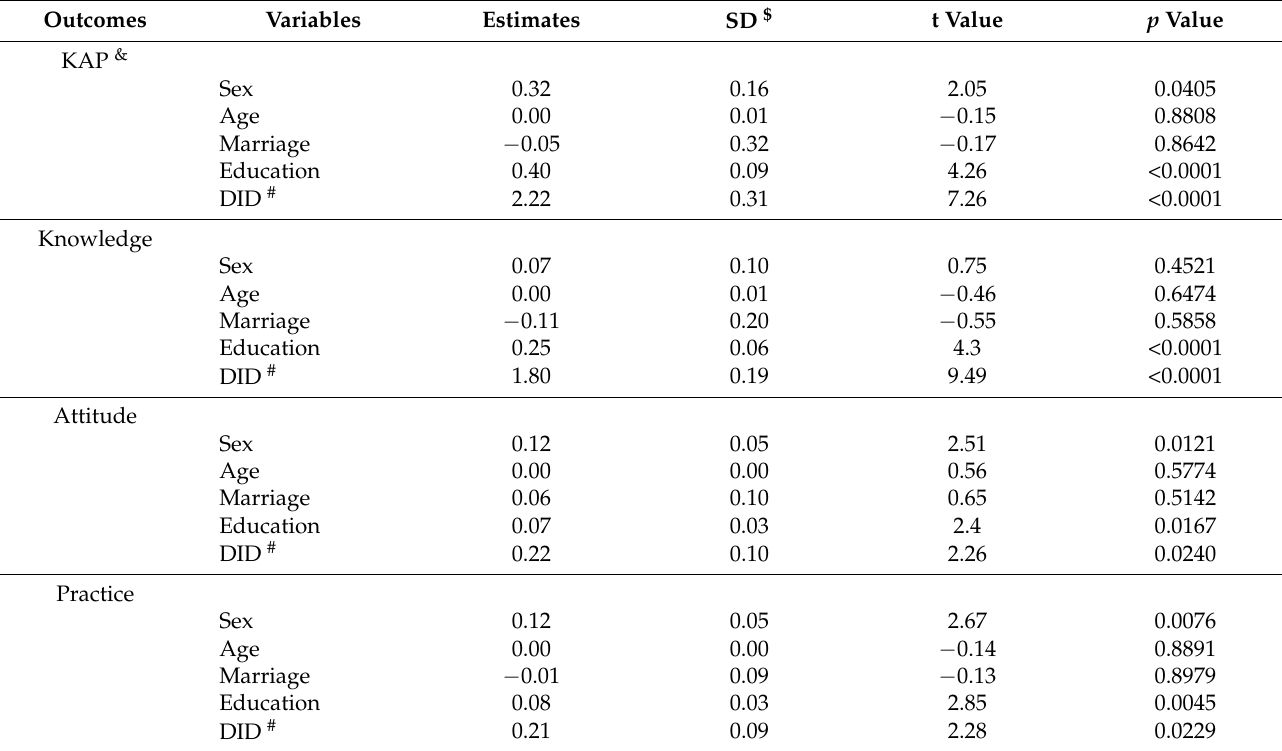
Table 5. The estimates of effects of sex, age, marriage, and education on KAP change of parents after intervention, from DID